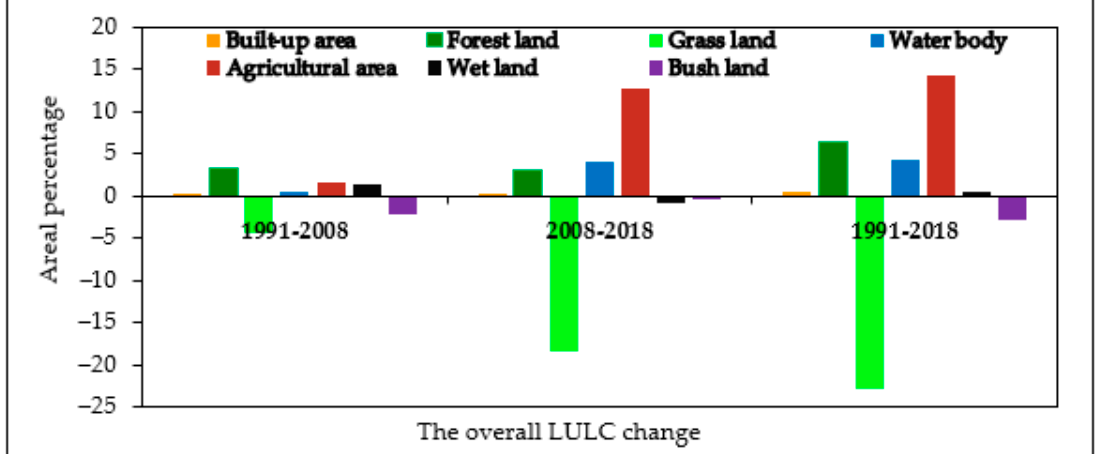
Figure 6. Graphical expression of LULC change detection from 1991 to 2018.